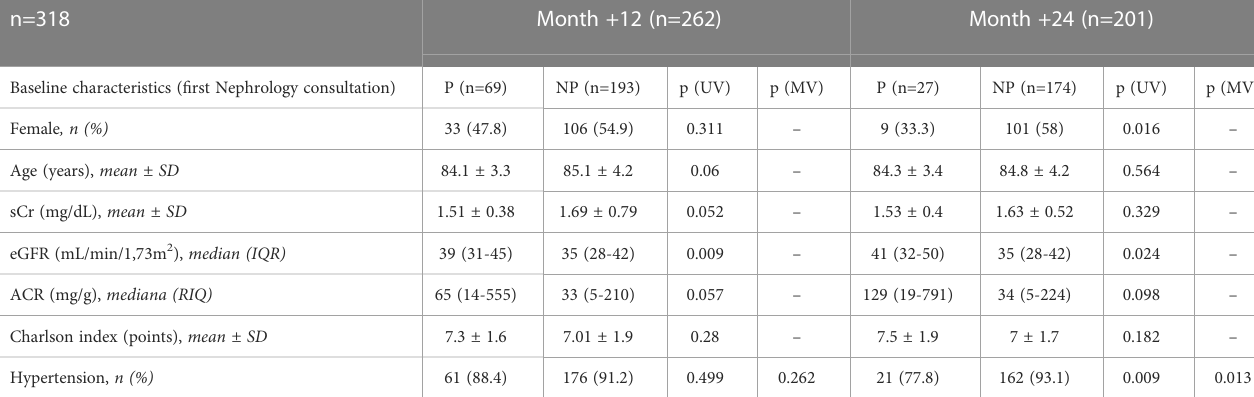
TABLE 4 Progression related factors after 12 and 24 months in all patients.